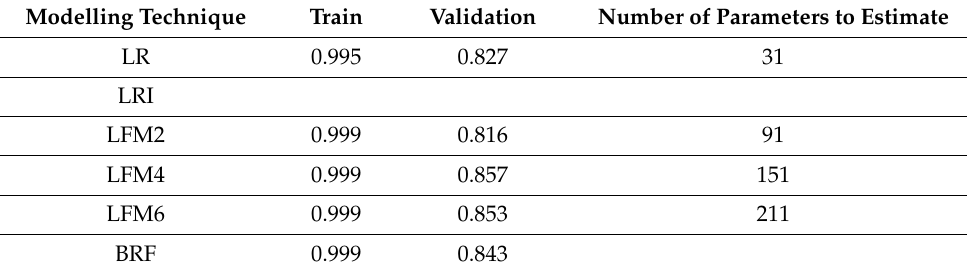
Table 14. Ginis obtained by the models on the reduced data set.